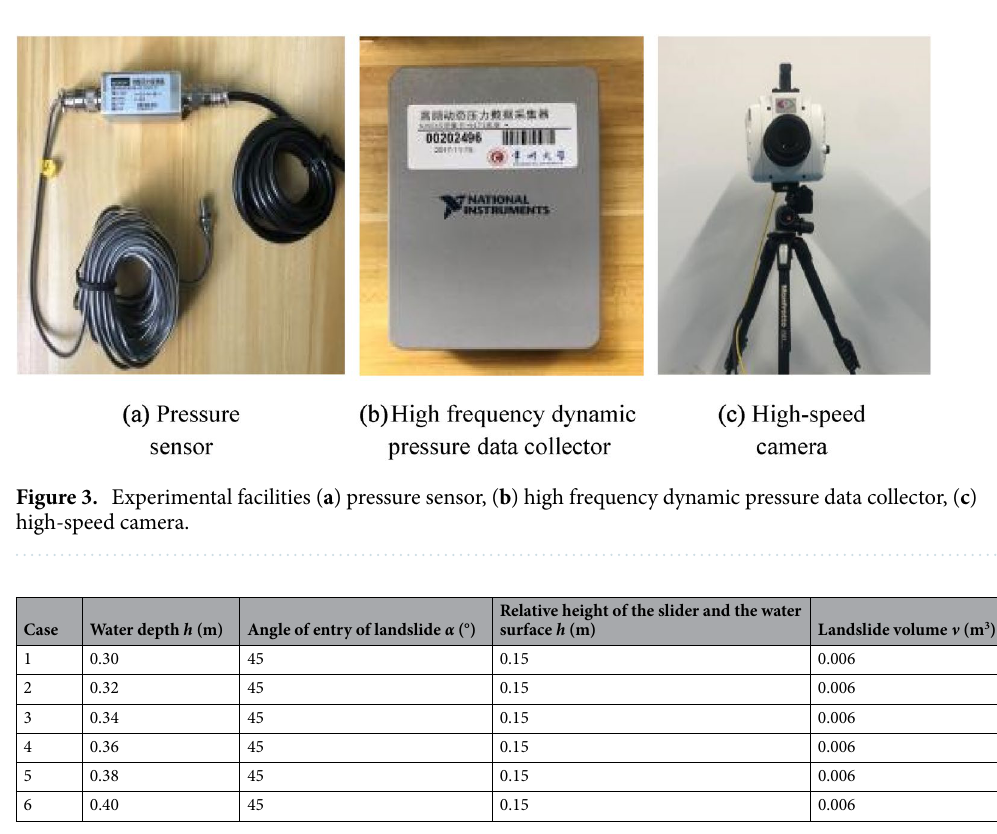
Table 1. Parameter